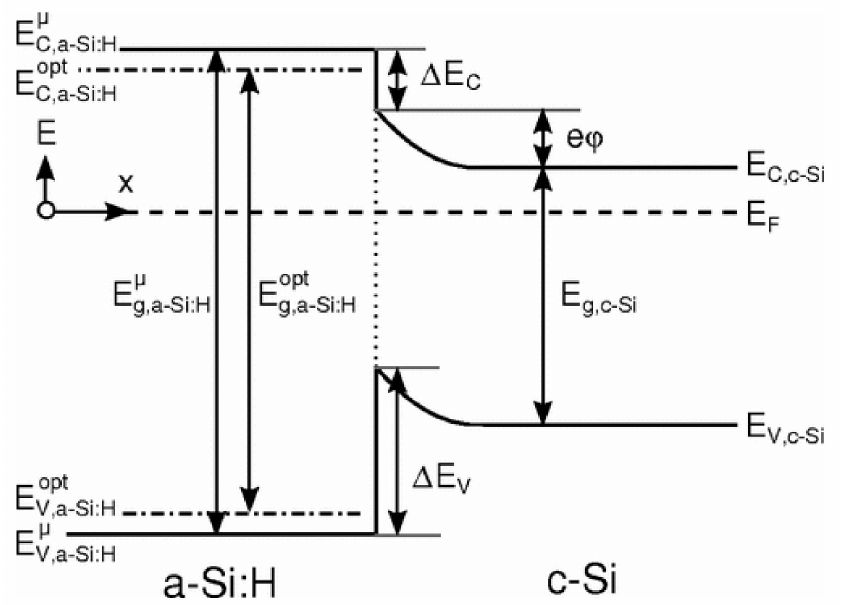
Figure 3. Energy band diagram of the a:Si-H(i)/n-Si heterojunction showing conduction and valence band offsets and band bending in n-Si (Adapted with permission from Ref. [46] 2011, American Physical Society, http://dx.doi.org/10.1103/PhysRevB.83.165314 (accessed on 16 June